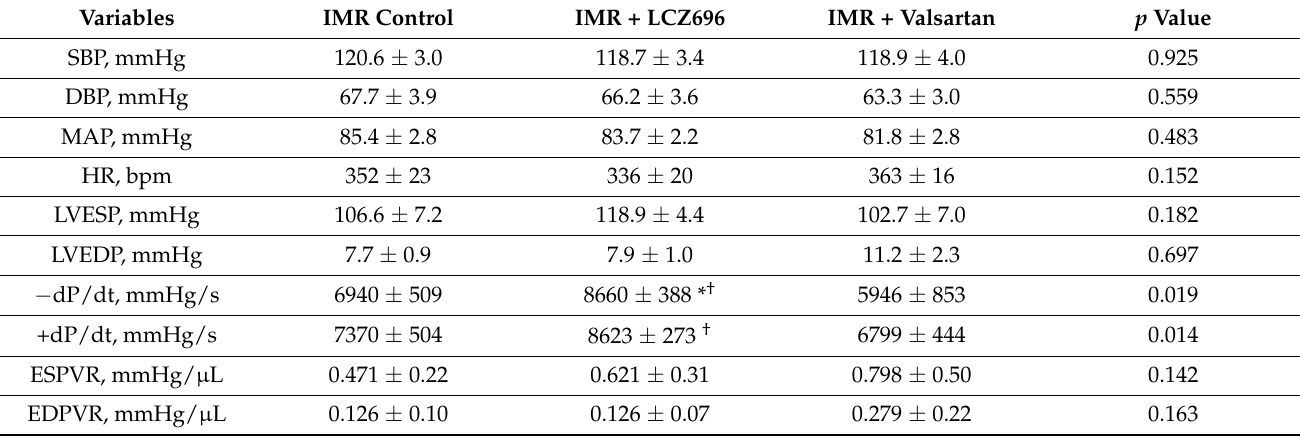
Table 1. Hemodynamic parameters 6 weeks after myocardial infarction.